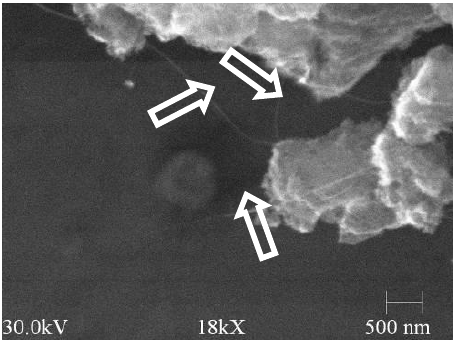
Figure 3. SEM of Commercial MicroTechNano